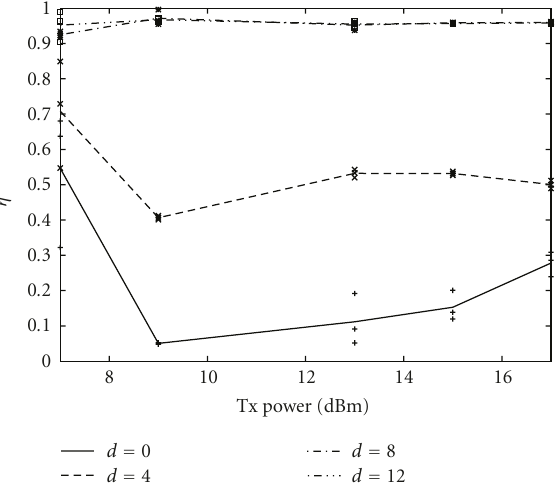
Figure 16: Far links, 802.11a: impact of channel separation and transmitted power on throughput.